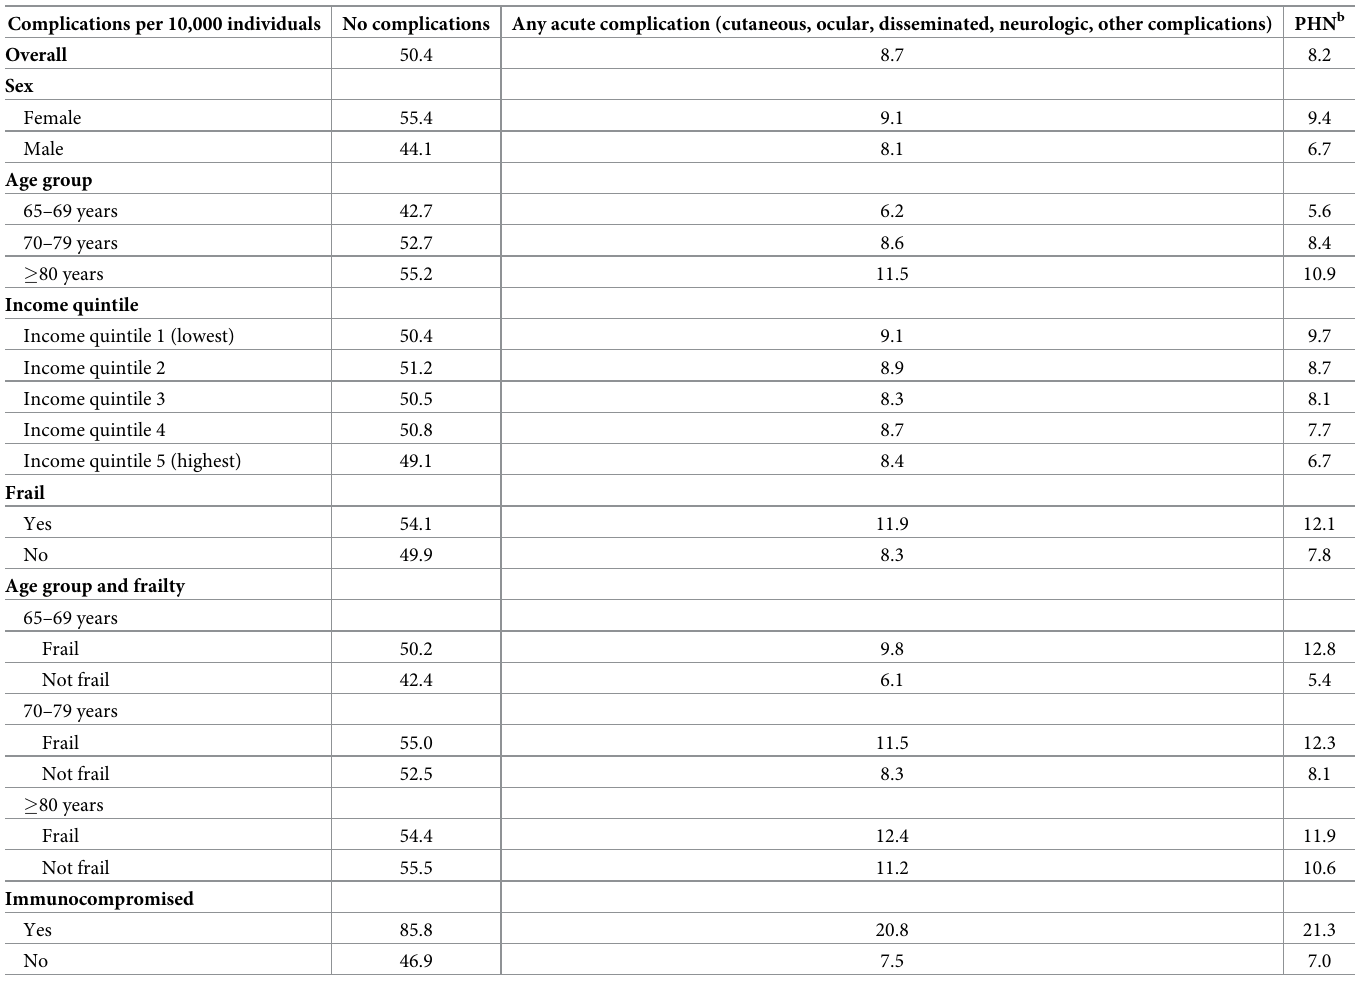
Table 3. Average annual incidence of herpes zoster complications a per 10,000, 2002–2016.